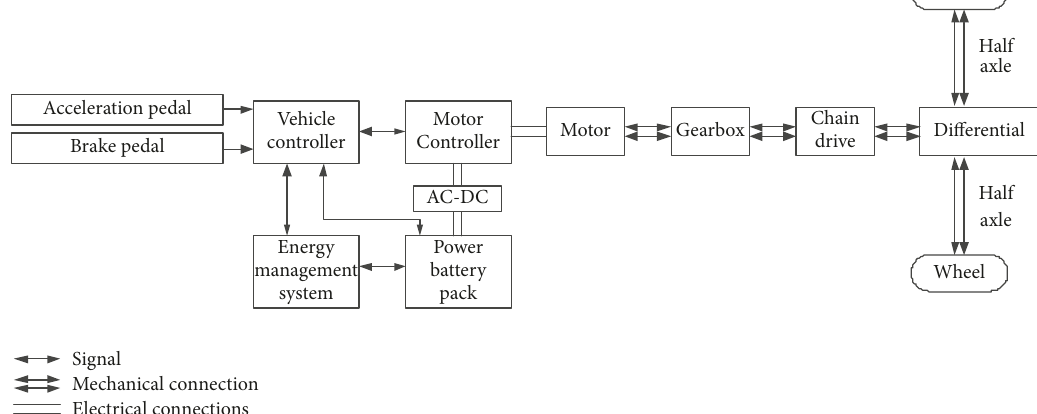
Figure 9: HRT-15E racing power transmission